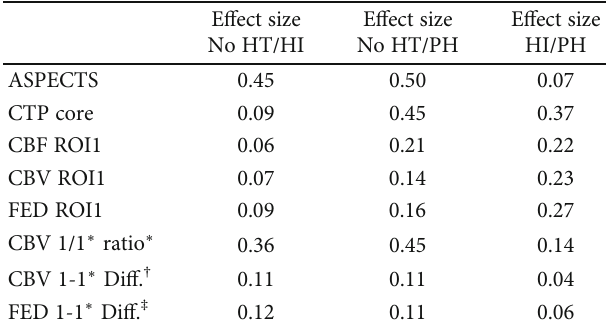
Table 3: E ff ect size for bleeding